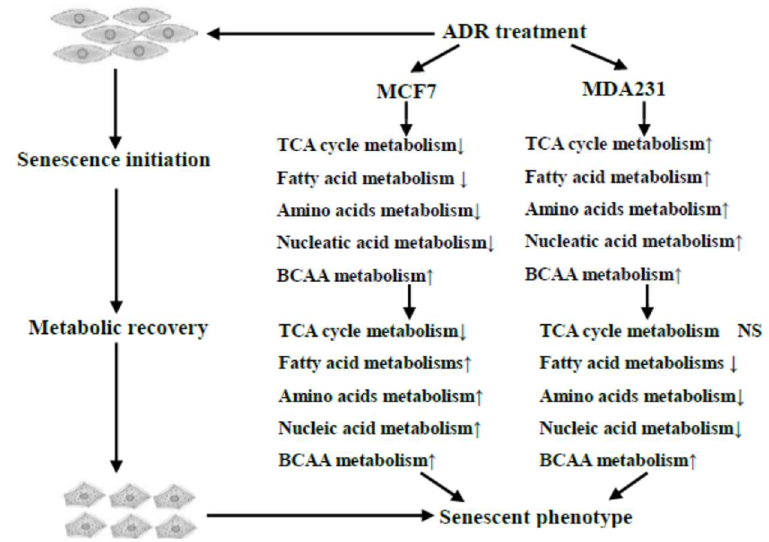
Figure 7. Overview of the dynamic metabolic changes during ADR-induced cell senescence.